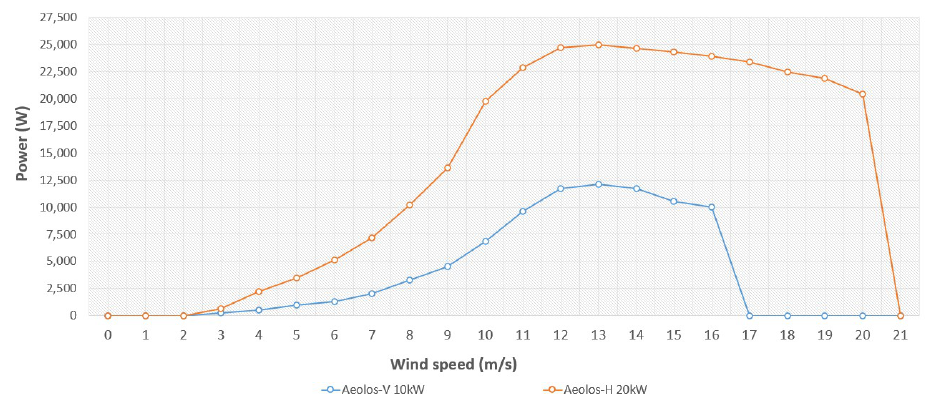
Figure 2. Turbine power